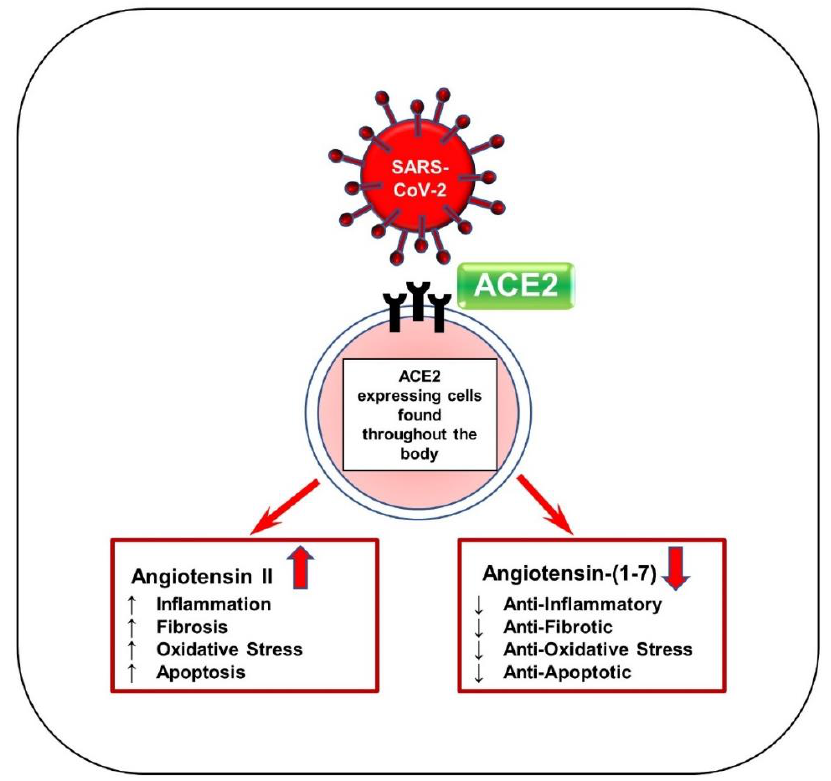
Figure 2. Schematic of SARS-CoV-2 viral entry via ACE2 receptor. SARS-CoV-2 enters the body by first binding to ACE2 receptors by the S protein. ACE2 is responsible for generating Ang-(1–7) from Ang II and acts mainly to reduce blood pressure. This binding can block the ACE2 receptor and reduce ACE2 activity, thereby significantly increasing Ang II levels and drastically decreasing Ang-(1–7) levels. Ang-(1–7) serves as anti-inflammatory, antifibrotic, antioxidative, and antiapoptotic. Ang II increases hypertension and other associated factors such as inflammation, fibrosis, oxidation, and